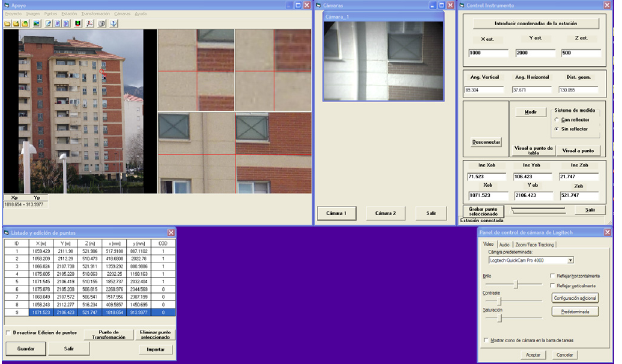
Figure 2. Control software interface